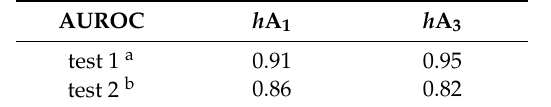
Table 3. Area under the ROC curve (AUROC) for the two homology